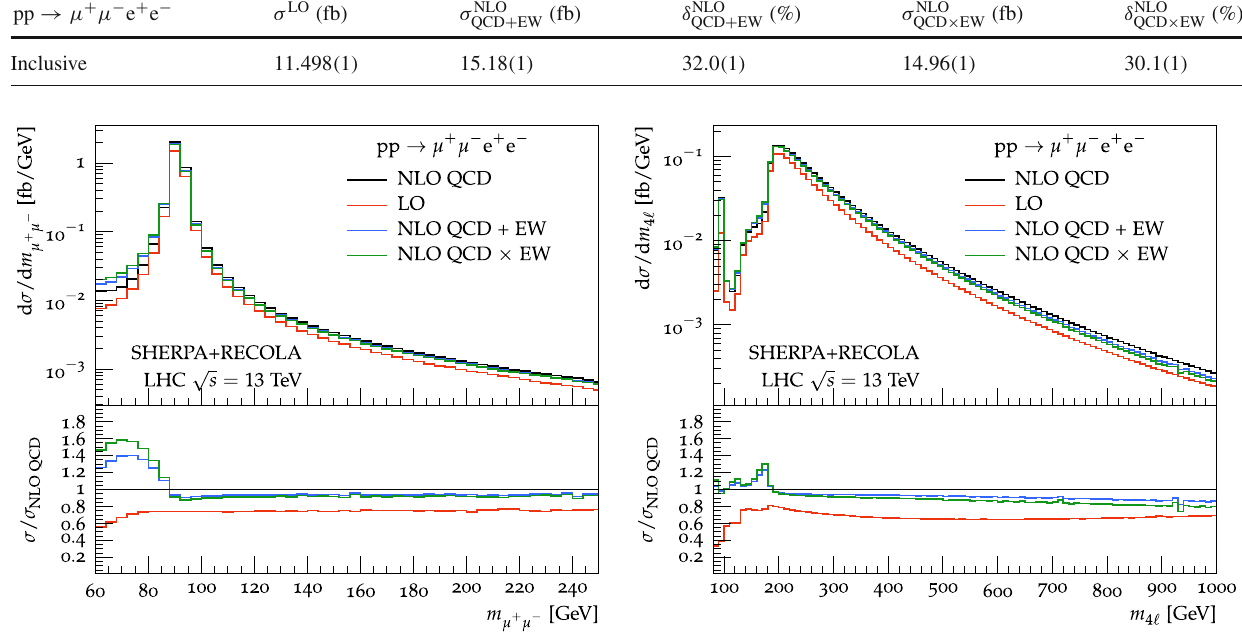
Table 12 Integrated cross sections for pp → μ + μ − e + e − for a centre- √ s = 13TeV, calculated with Sherpa + Recola for of-mass energy of the set-up of Ref. [27]. The cross sections at LO as well as for the addi- tive and multiplicative combinations of NLO QCD and EW corrections